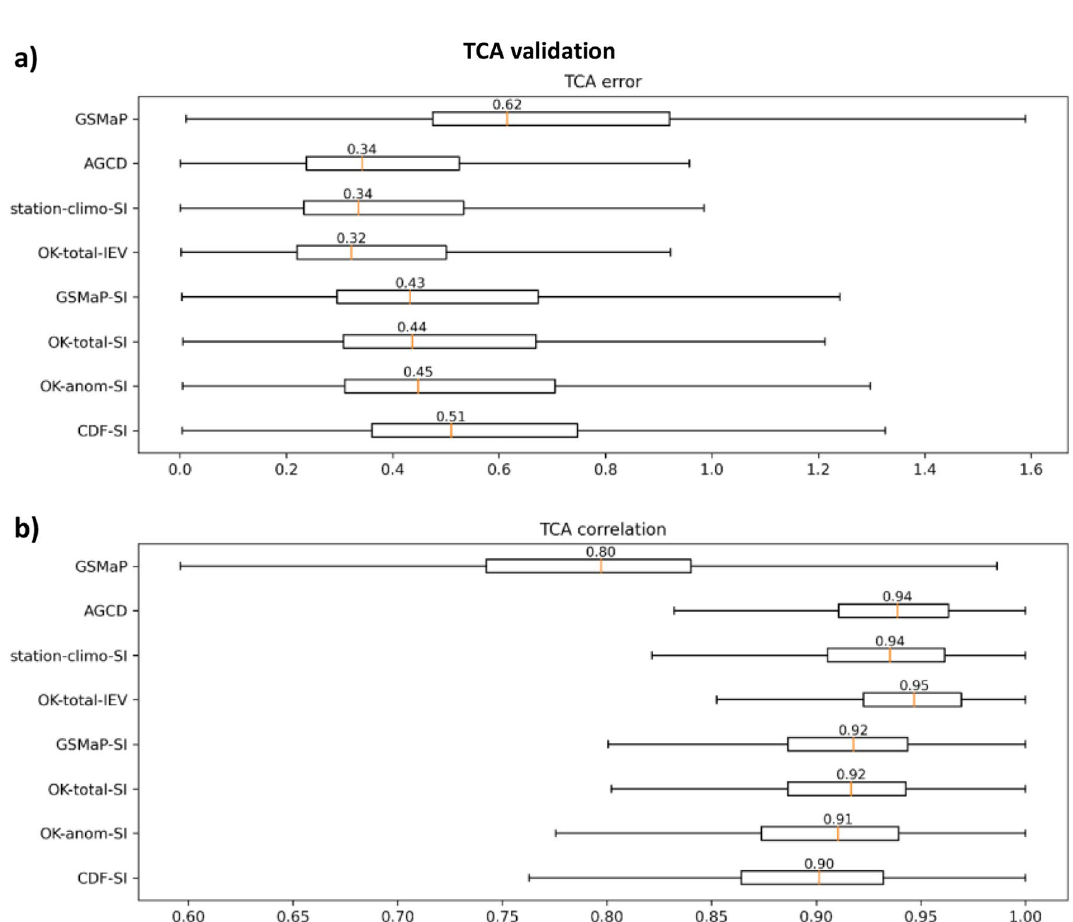
Figure 8. Boxplots of ( a ) correlation and ( b ) error statistics from TCA validation. The TCA error is in mm/ day while TCA correlation is unitless. A value of 0 and unity is ideal for the error and correlation respectively. The boxes indicate the interquartile range (IQR), the whiskers extend out to the non-outlier minimum and maximums (Q1 − 1.5 × IQR and Q3 + 1.5 × IQR), and the line within the box represents the